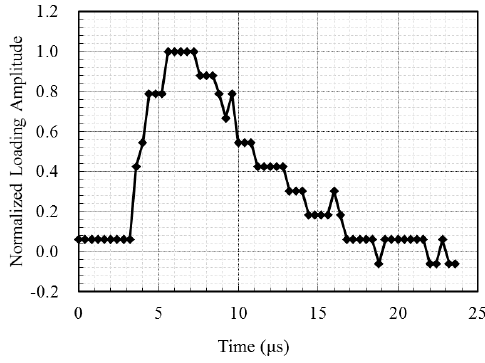
Figure 4. Excitation signal measured in the experimental study.